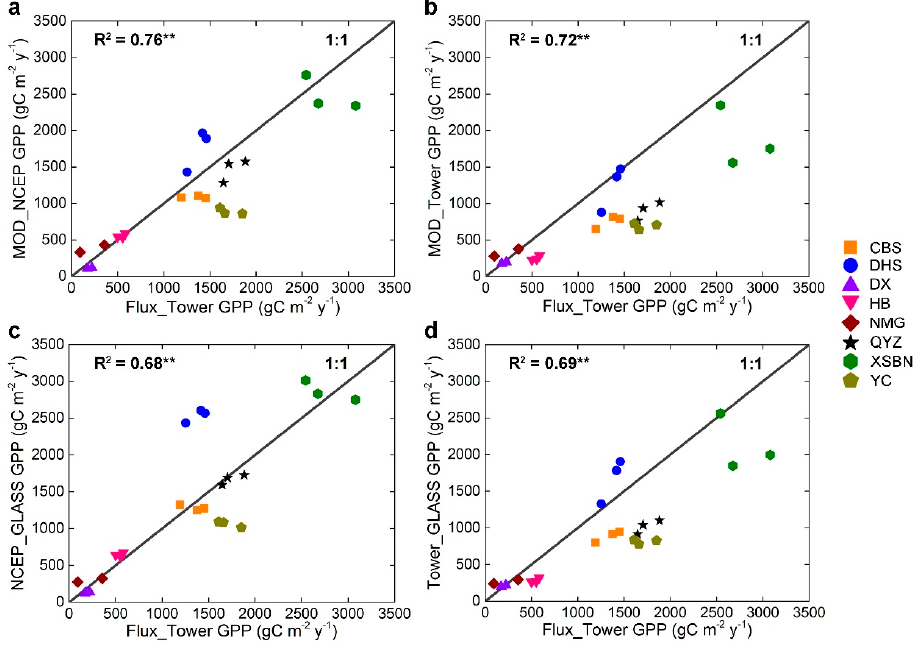
Figure 8. Comparisons of the annual Flux_Tower GPP with: ( a ) MOD_NCEP GPP; ( b ) MOD_Tower GPP; ( c ) NCEP_GLASS GPP; and ( d ) Tower_GLASS GPP. Significance levels: ** p < 0.01.